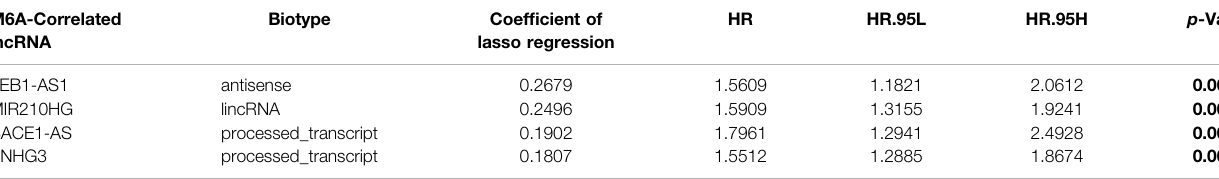
TABLE 2 | Four selected m6A-correlated prognostic lncRNAs.